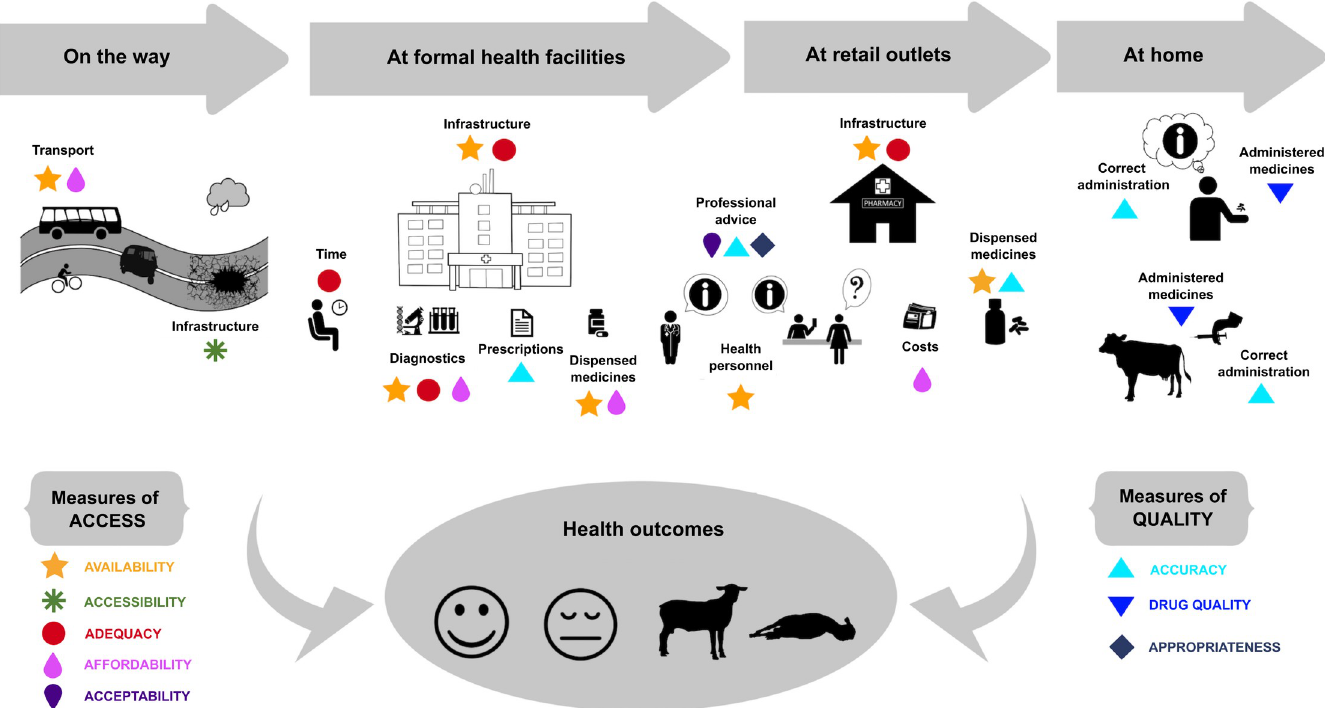
Fig 1. Components of the healthcare system and health-seeking process. The shapes show where shortcomings in access or quality of human and animal healthcare could happen and impair ideal health provision. They also indicate the dimension of the framework affected.